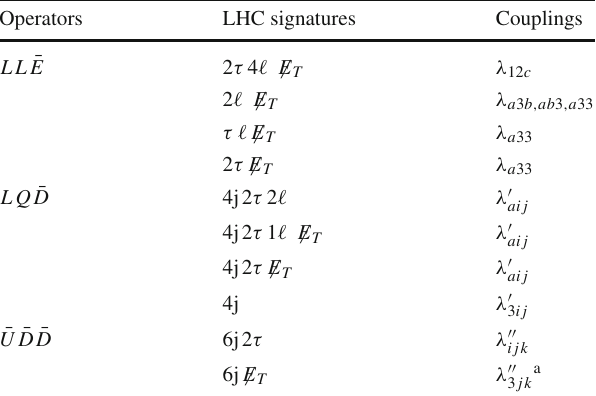
Table 9 LHC signatures for a stau LSP from the decay of two staus. a , b , c = 1 , 2; i , j , k = 1 , 2 , 3. We did not distinguish between top quarks,bottomquarksandthejetsarisingfromthefirsttwogenerations. These are analogous to Tables 5 and 7. The special case in the last line denoted with a refers to scenarios where the stau LSP is light so that the decay into a top quark is kinematically disfavored, leading to the dominance of the chargino-mediated final state ν τ d 3 d j d k as in Eq. (34) Operators LHC signatures